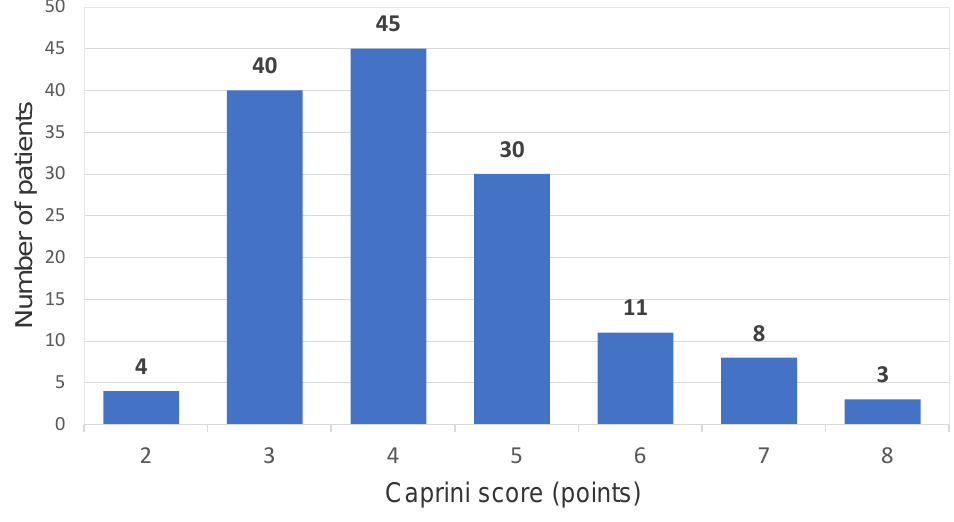
Figure 1. Caprini score results in the study population.